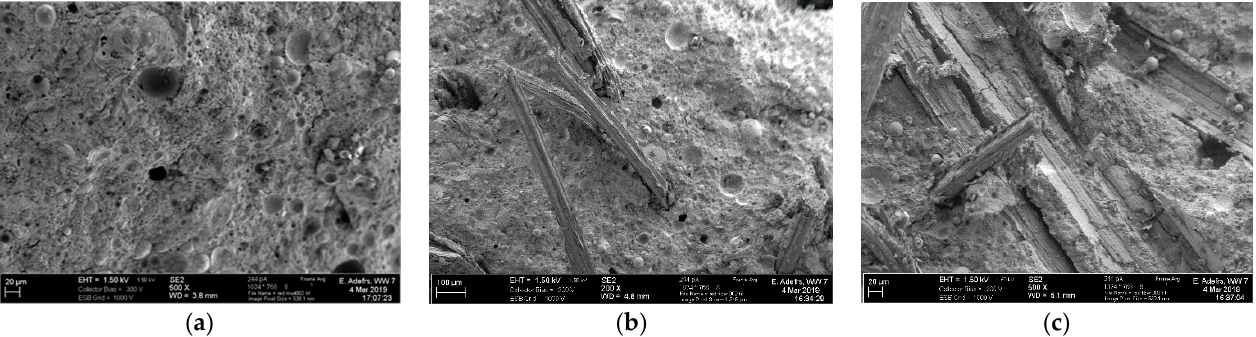
Figure 5. SEM images (fracture surface) of ( a ) plain geopolymer, and ( b , c ) geopolymer reinforced with hemp fiber (9 vol.%) and prepared by 8M NaOH at two different magnifications.